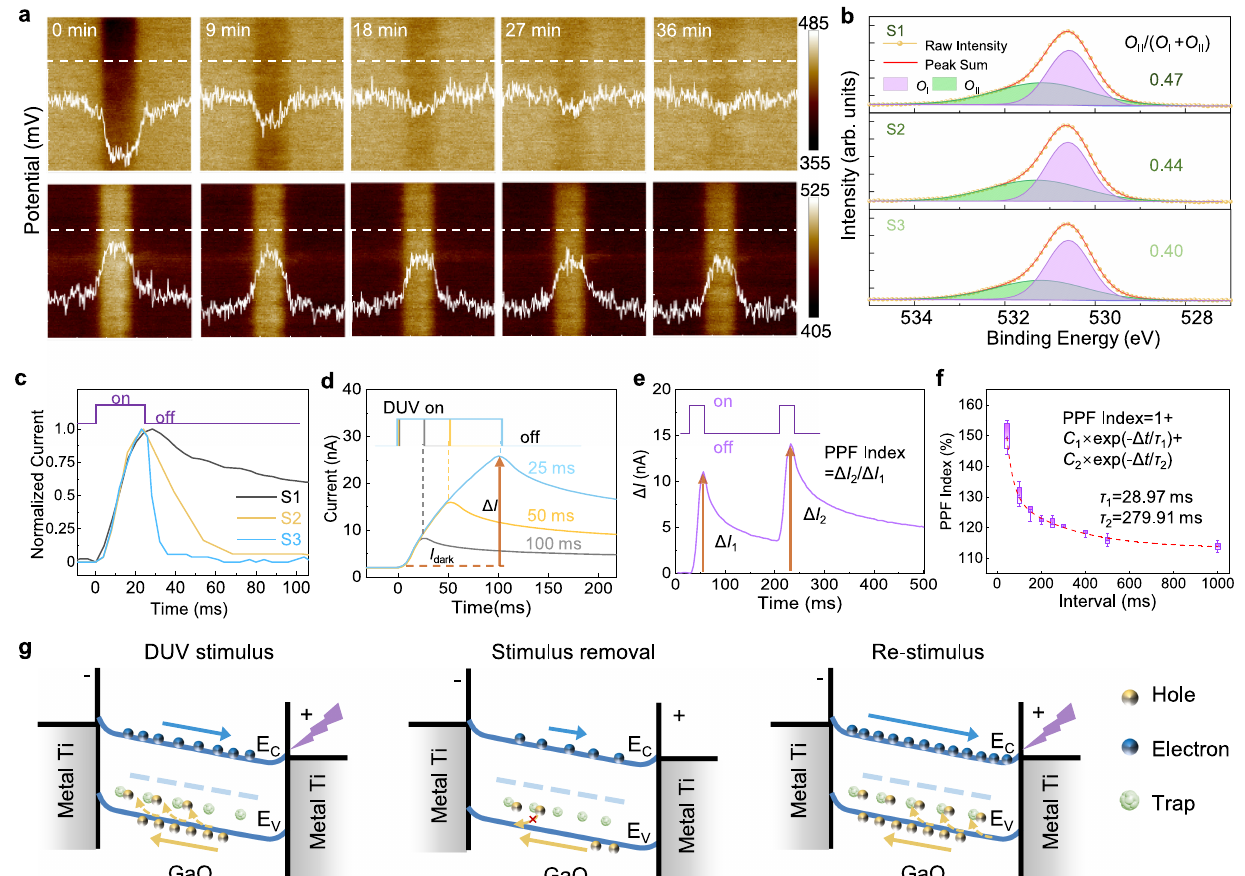
Fig. 2 | PPC effect and synaptic behavior of the a-GaO x DUV sensor. a KPFM resultsofthea-GaO x surfaceafterinjectingelectrons(toppanel)andholes(bottom panel) by negative/positivebiasing. The insetineach image indicatesthepotential pro fi le along the white dashed line. b XPS spectral fi tting of the O1 s peak of the a-GaO x fi lm with different oxygen contents (S1, S2, and S3). c The normalized photoresponse I-t curvesofthea-GaO x fi lmswithdifferentoxygencontents(S1,S2, and S3). d The macroscopic PPC and volatile STM effects observed in Ga 2 O 3